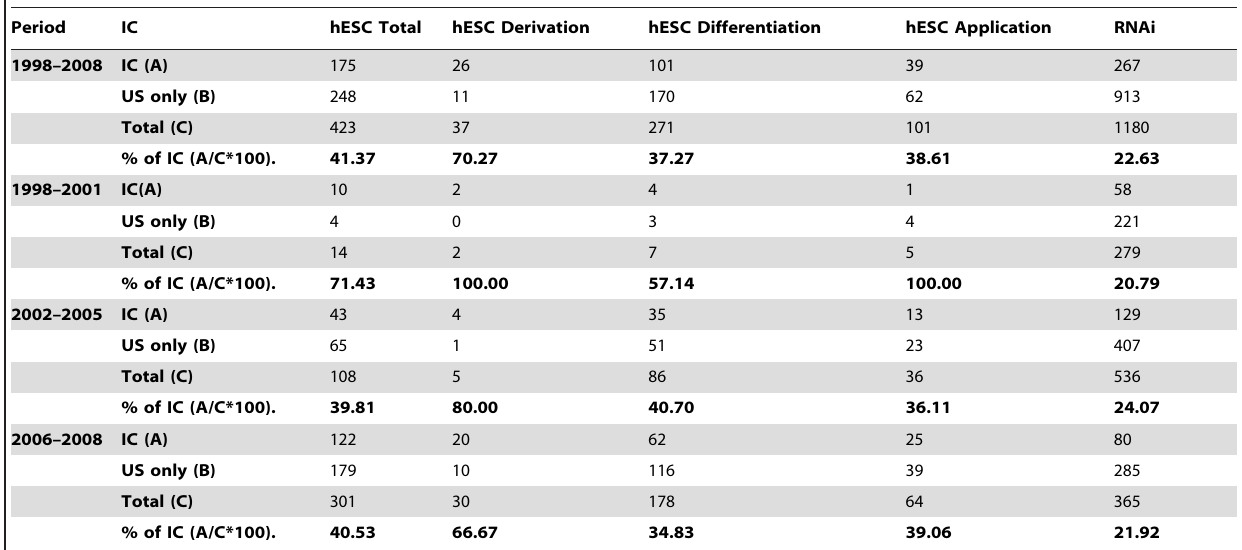
Table 1. International Collaboration by US